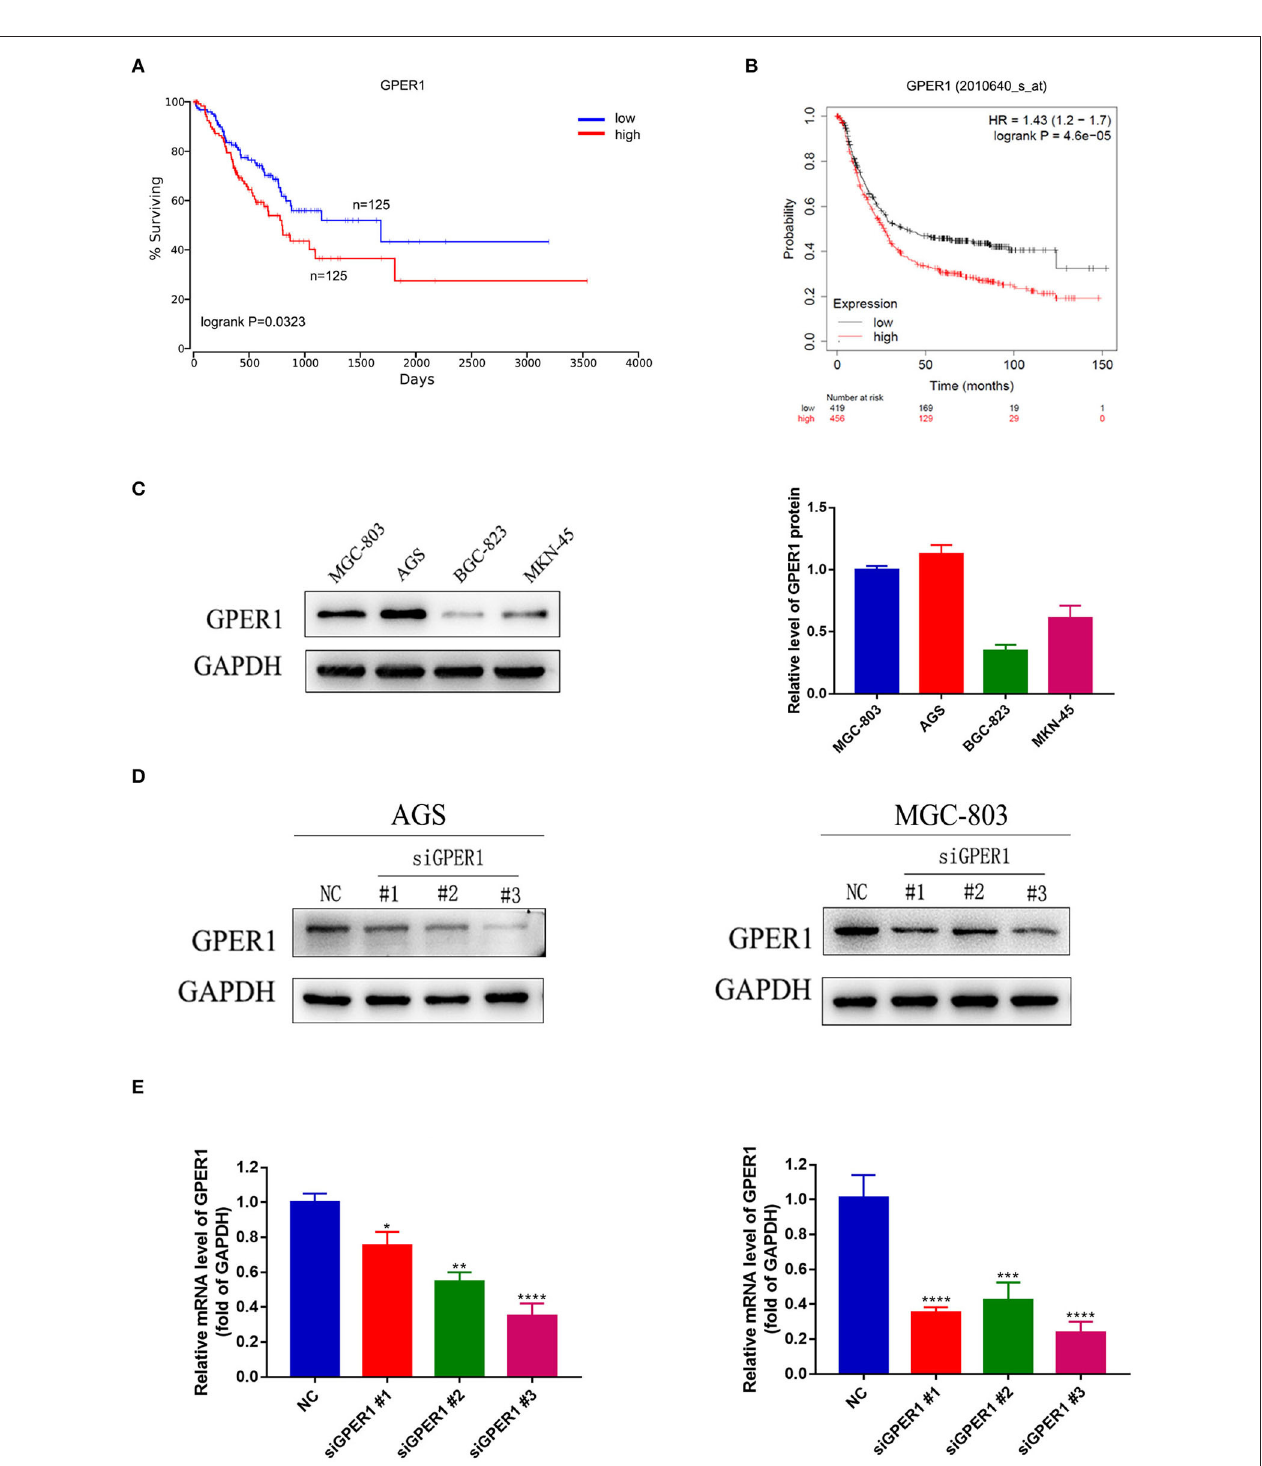
FIGURE 1 | Correlation between GPER1 expression and prognosis in gastric cancer, GPER1 expression in different gastric cancer cell lines, and verification of transfection efficiency. (A,B) Correlation of GPER1 expression in gastric cancer patients with overall survival rate; (C) Western blot of GPER1 protein and gene expression in four gastric cancer cell lines; GAPDH was used as a loading control; (D,E) Protein and gene expression levels of GPER1 in AGS and MGC-802 cells transfected with siRNA targeting GPER1. Results were shown as mean ± SD of three independent experiments, each experiment was performed in triplicate. * P < 0.05; ** P < 0.01; *** P < 0.001; **** P < 0.0001.